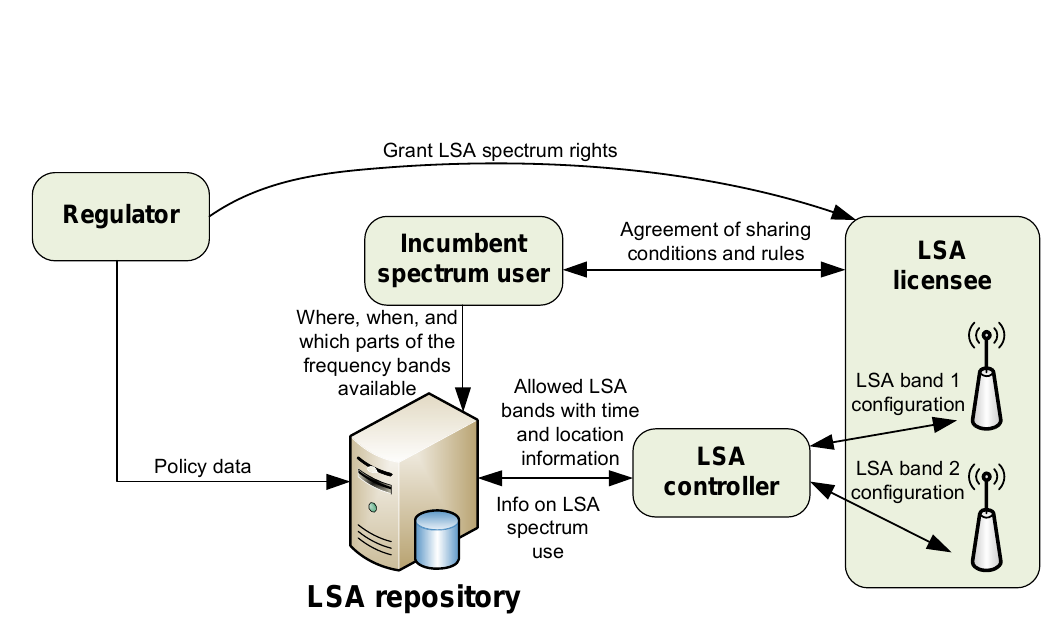
Figure 1. LSA functional